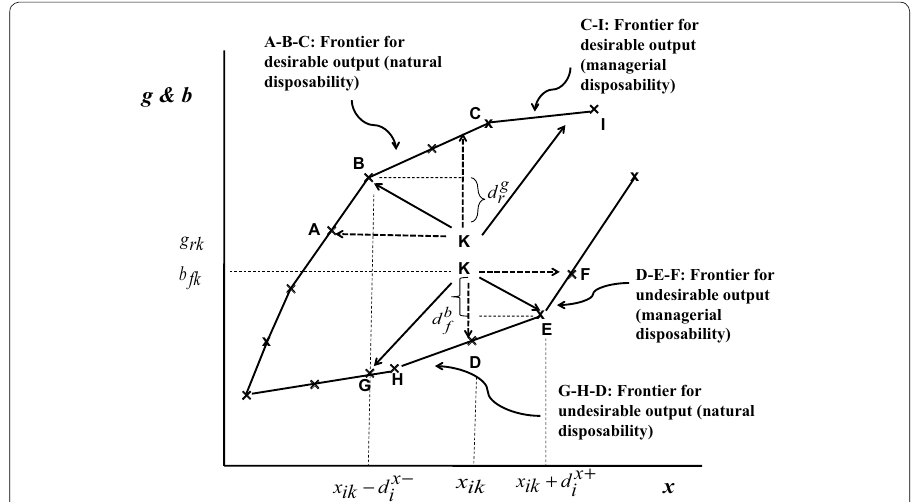
Fig. 1 Two efficiency frontiers for measuring unified efficiency. (a) The direction of NW (North-West) indicates a projection of K toward an efficiency frontier ( A–B–C ) that is incorporated into the conventional framework of DEA. (b) DEA environmental assessment incorporates the projection of SW (South–West) from K toward an efficiency frontier ( G–H–D ) under natural disposability and the projection of SE (South–East) from K toward an efficiency frontier ( D–E–F ) under managerial disposability. The projection of NW serves as a basis for the performance assessment of conventional DEA. The projection of NE (North-East) toward an efficient frontier ( C–I ) has been excluded from the conventional use. The proposed environmental assessment incorporates the projection toward NE along with an increase in components of an input vector. (c)